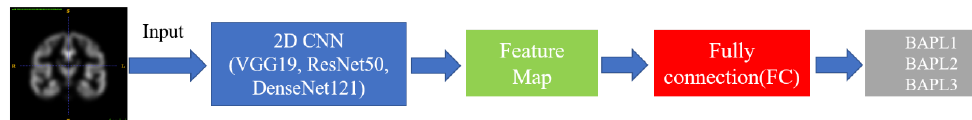
Figure 2. Convolutional neural network (CNN) architecture.